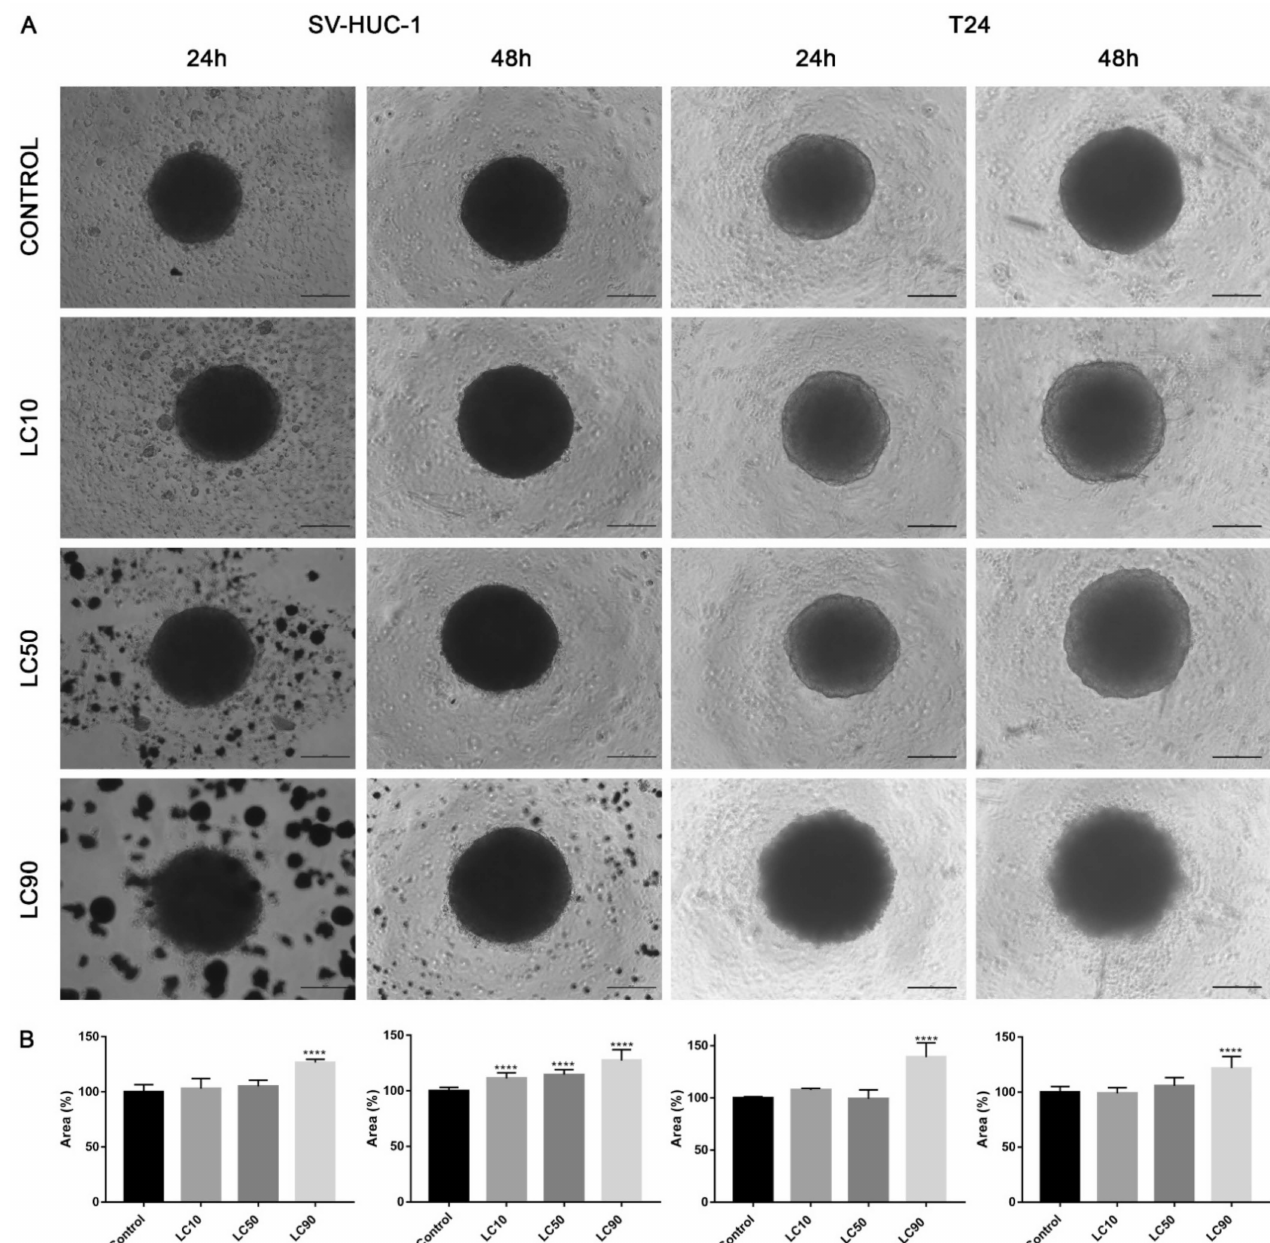
Figure 8. Morphology of urothelial cells in 3D cell culture following ciprofloxacin treatment. ( A )—T24 and SV-HUC- 1 cell lines treated with calculated lethal concentration obtained for ciprofloxacin, using an inverted light microscope (bar = 200 µ m). ( B )—Morphometric analysis of spheroids area. SV-HUC-1—non-malignant human urothelium; T24— human bladder cancer; LC—lethal concentration; statistically significant results compared to control were presented: ****— p ≤